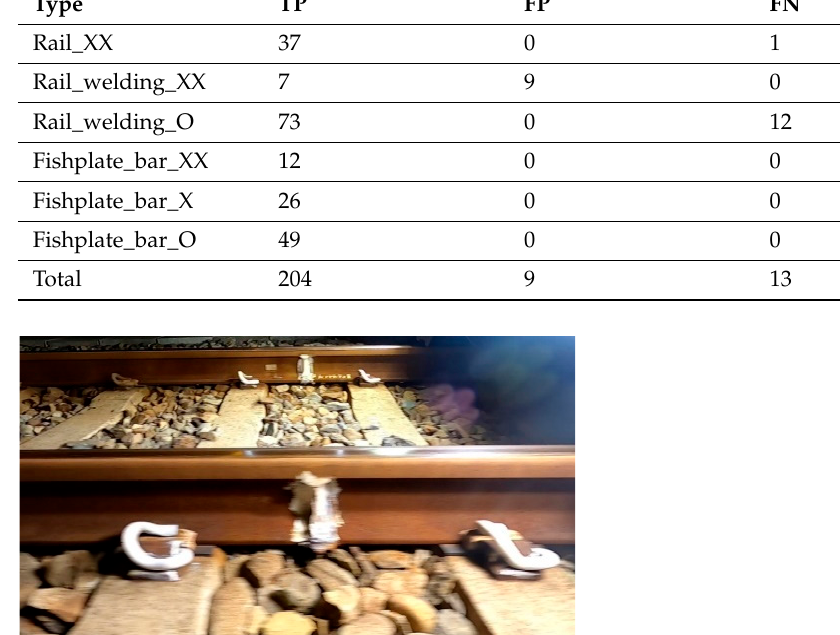
Figure 11. A FN example of Rail_welding_XX.